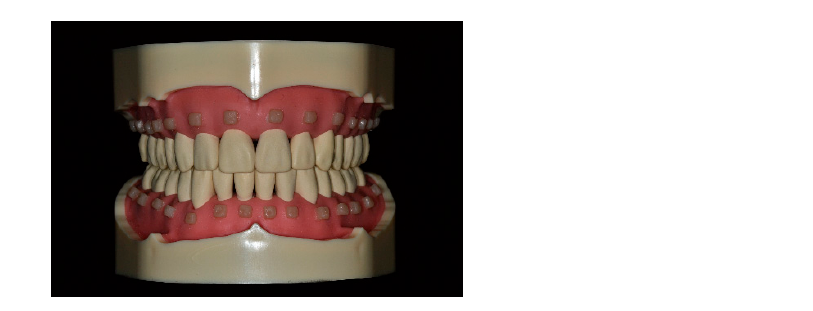
Figure 1. Experimental workflow.